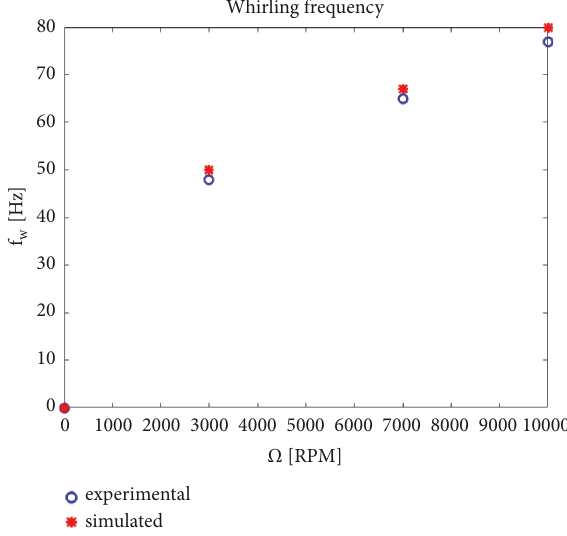
Figure 39: Comparison between experimental and simulated for- ward whirl